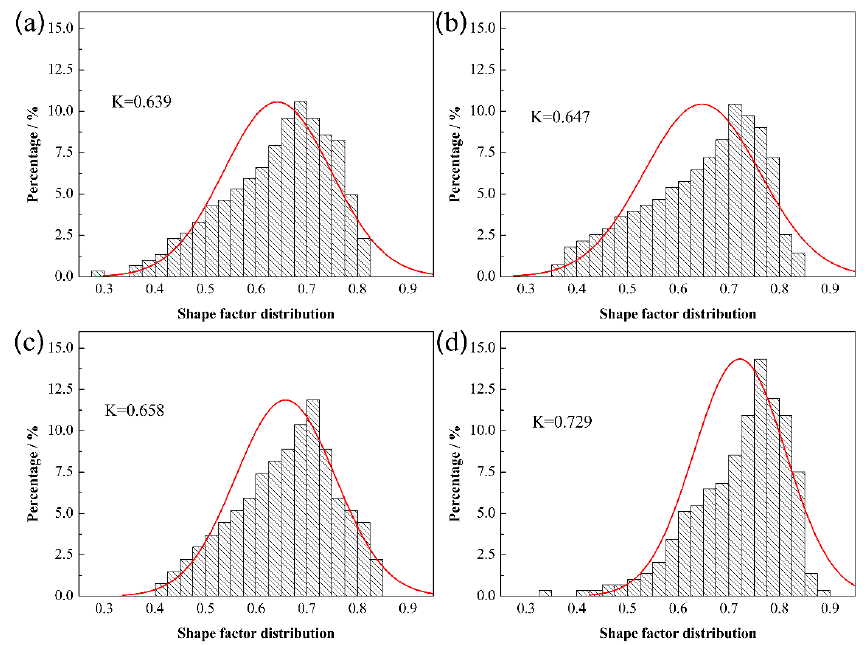
Figure 7. Shape factor distribution of Mo 2 FeB 2 with different Mo contents: ( a ) 43.5 wt.%; ( b ) 45.5 wt.%; ( c ) 47.5 wt.%; ( d ) 49.5 wt.%.